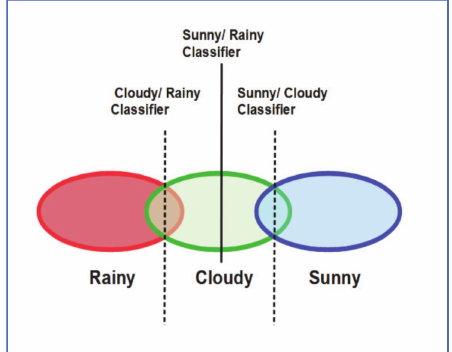
Figure 3. Different weather situations and classifiers